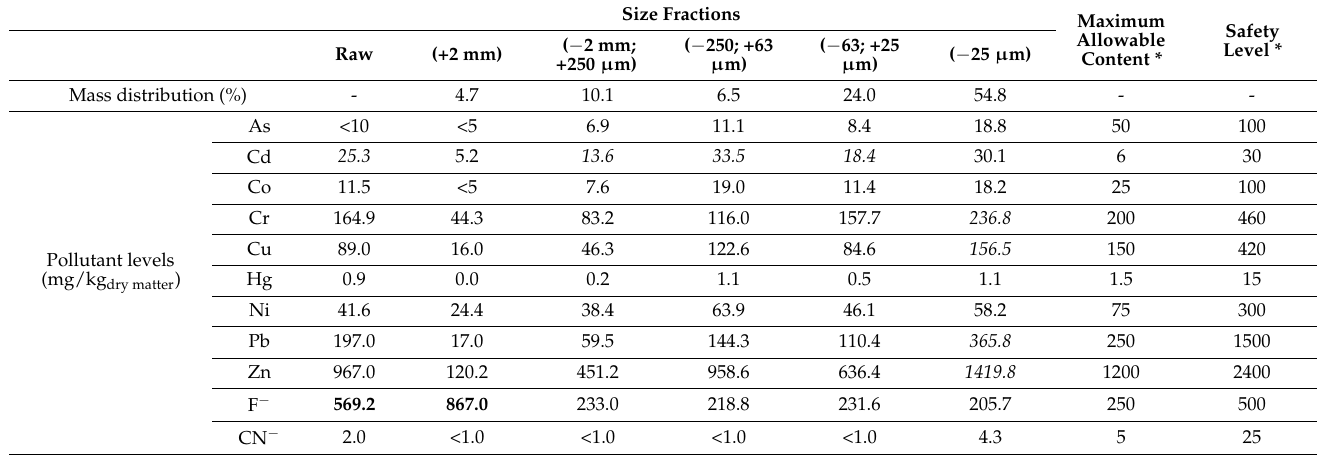
Table 4. Mass content distribution and inorganic pollutant level distribution inside ALS sediment compared to the thresholds specified in [42]. Size